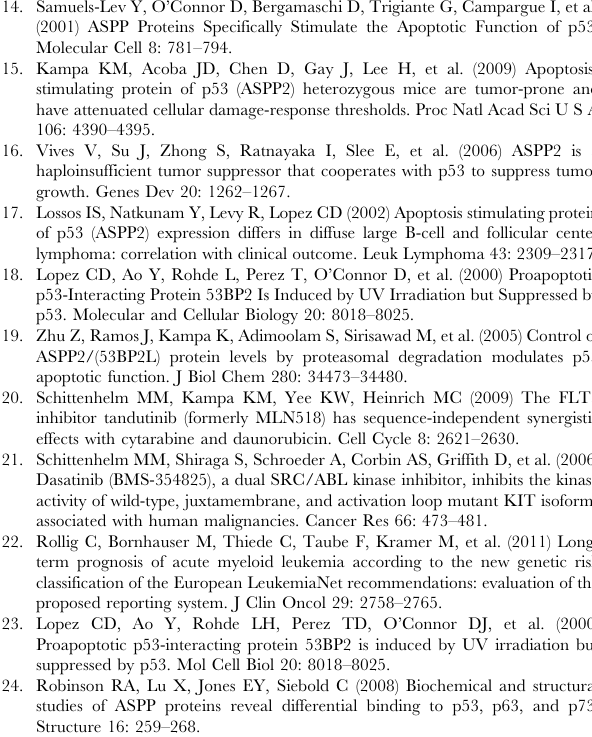
Figure S1 ASPP2 mRNA levels translate into protein expression levels. Protein lysates of native leukemia samples with a good- prognostic profile (patient characteristics are provided with Table 1) are immunoblotted to detect ASPP2 protein levels. The MCF-7 breast cancer cell line is used as a positive control to detect ASPP2 protein levels. The observed interindividual differences match with relative ASPP2 mRNA expression levels as determined by qRT-PCR against GAPDH as a housekeeping gene (bottom of the plot for each patient). (TIF) Figure S2 Methylation gDNA array. Five patients with prognostic higher-risk acute myeloid or lymphoblastic leukemia were analyzed in a methylation array to determine methylation status of ASPP2. Analysis of 20 probes spanning from the transcription start site (TSS) to the 3 9 -untranslated region (UTR) reveal high methylation patterns - particularly in the 5 9 UTR and immediate downstream coding regions (15/20 probes with a threshold of $ 10%; 10/20 $ 50%) in all tested patients.